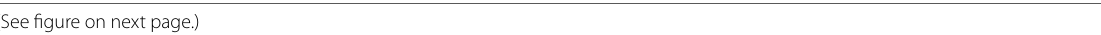
3 per group. NS: Not statistically = ) group. F Representative images of western blots − ) −